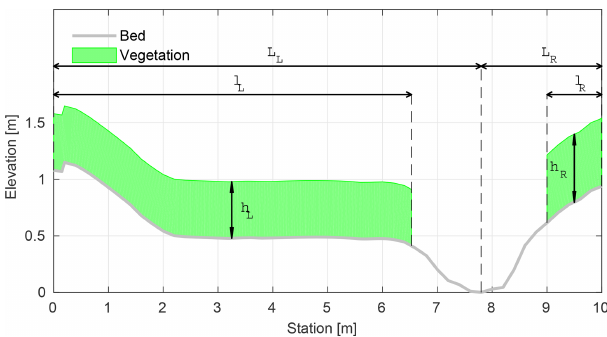
Figure 2. Parameterization of the blockage factor B X ; the cross section for Ritobacken Brook (Västilä and Järvelä,